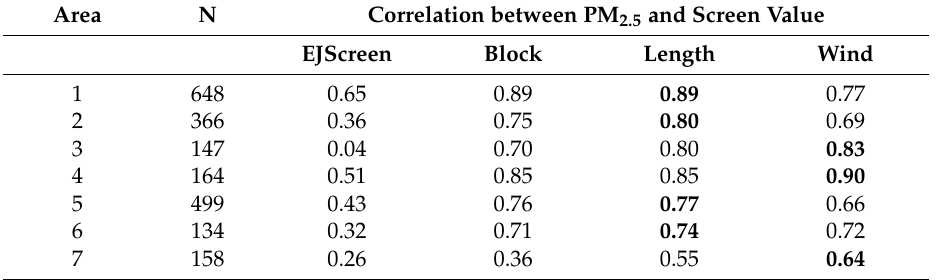
Table 2. Correlation between PM 2.5 and roadway air pollution screening index for populated blocks. Bold values indicate the highest correlations for each sample